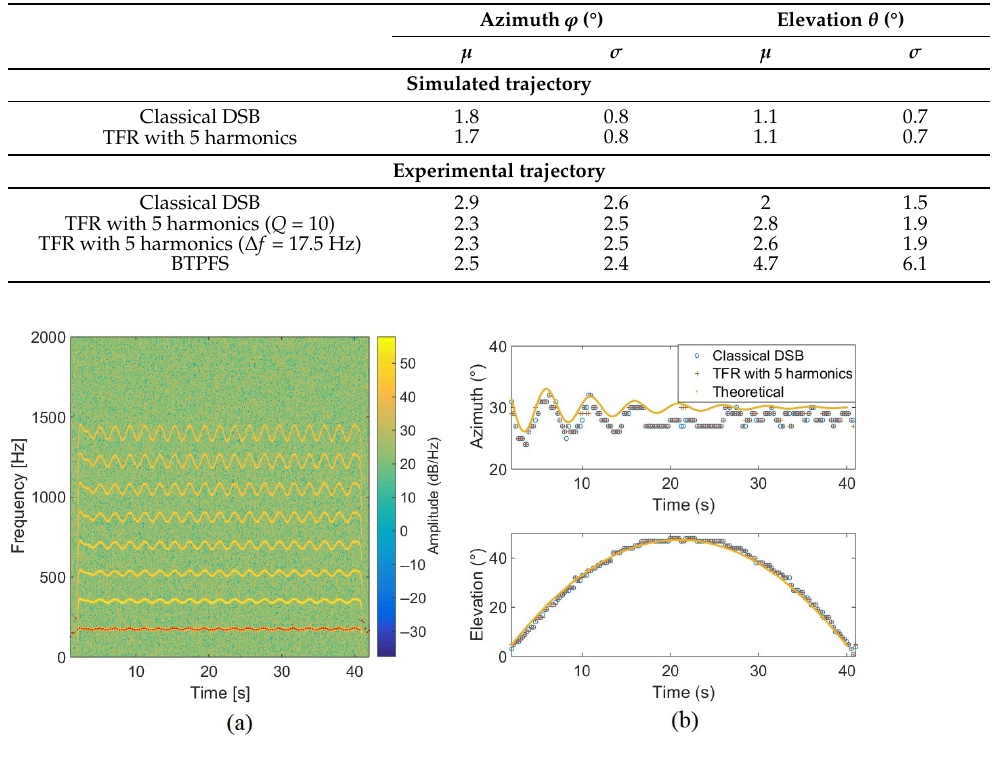
Figure 12. Spectrogram of the simulated source with the estimated frequencies in red ( a ). Evolution of the azimuth and elevation in time with the classical DSB, the TFR, and the theory ( b